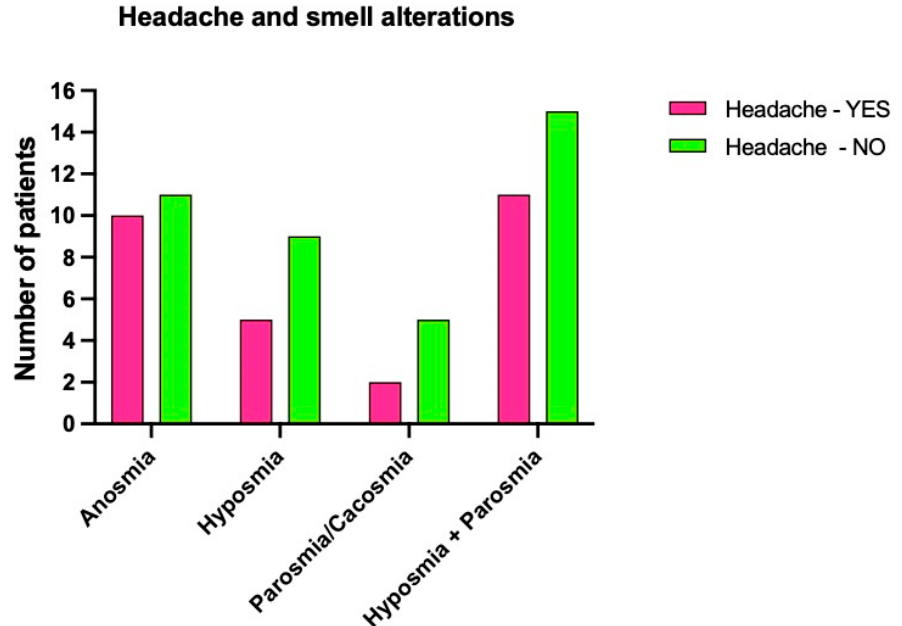
Figure 4. shows smell alterations patients that reported headache.